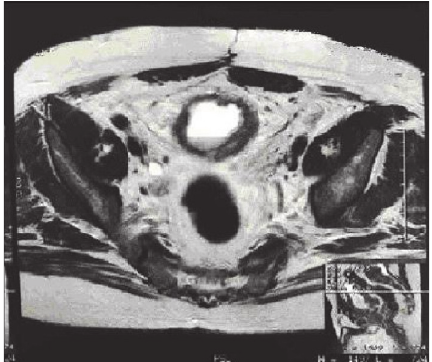
Figure2:MRIscansection:theMRIscanrevealedvesicalthickened walls, more evident in the lower third of the bladder, associated with an exophytic